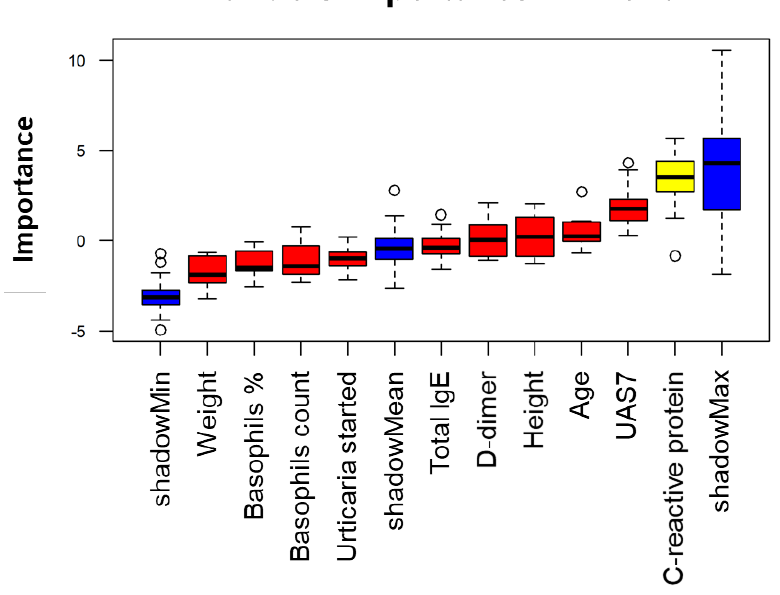
Figure 7. Feature selection algorithm based on importance.